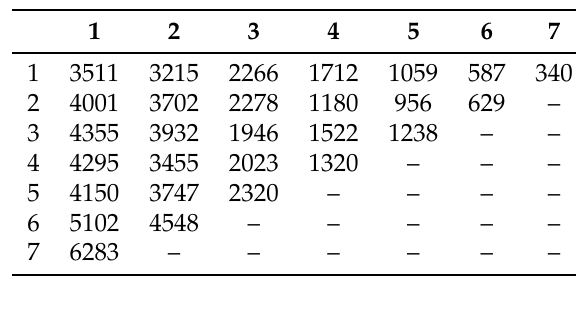
Table 2. Incremental run-off triangle for macro-level model (in